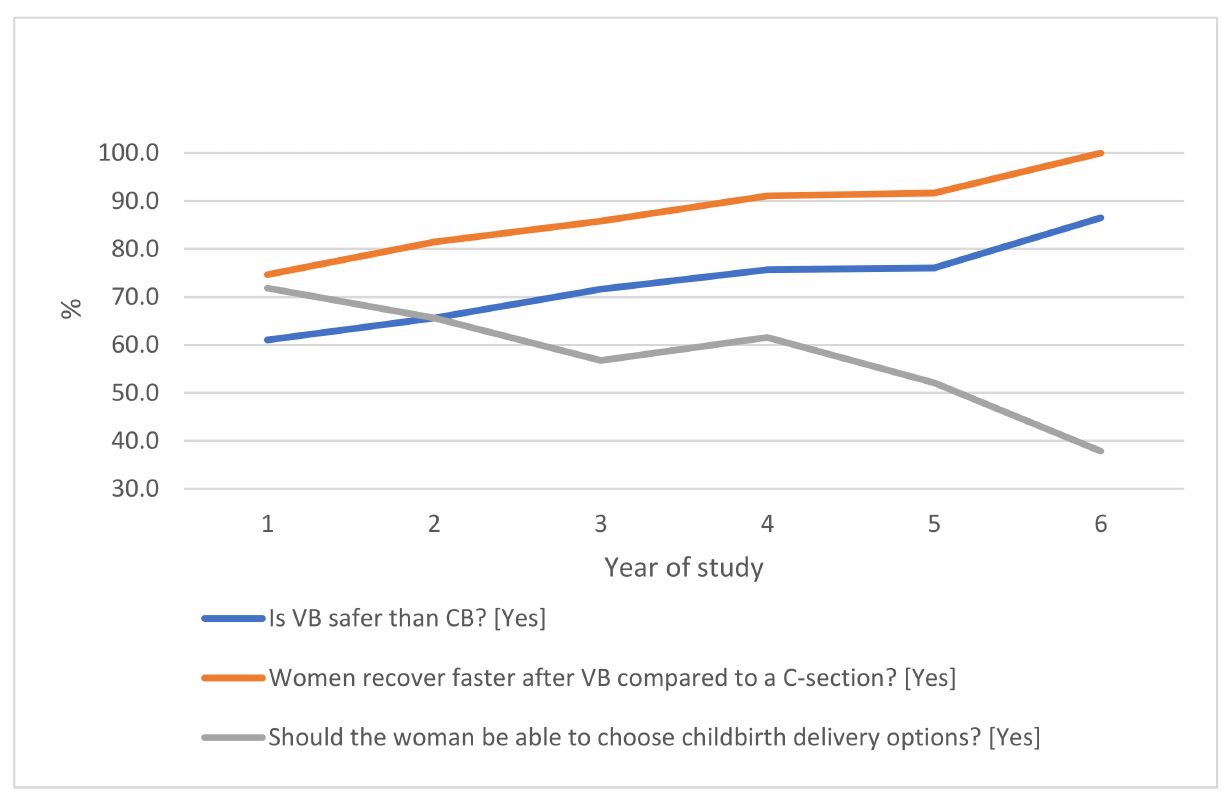
Figure 2. Changes in students’ opinions about VB and CS over years of